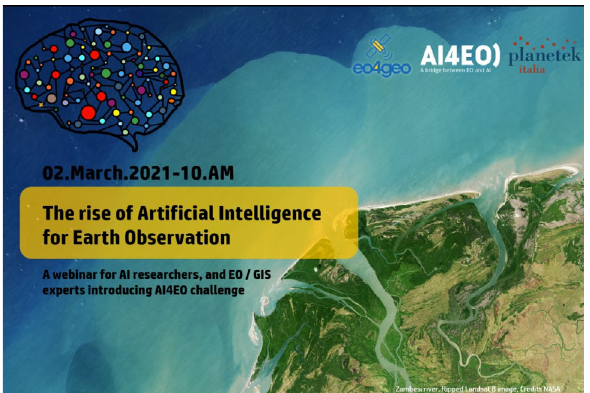
Figure 11 . Webinar on AI for Earth Observation, posted on the EO4GEO website 9